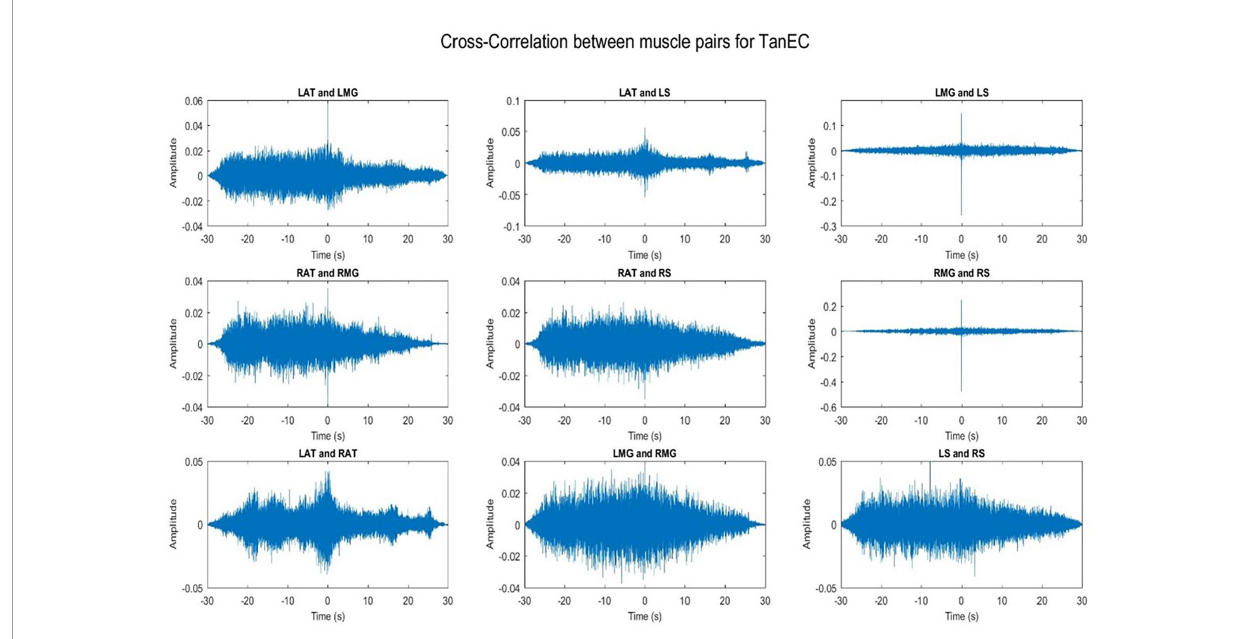
FIGURE3 Cross-correlation of different muscle pairs under TanEC condition for a single participant for a single trial. The figure represents cross-correlation between the EMG signals of different muscle pairs under the least stable postural standing position. It shows negligible cross talk between the muscle pairs.